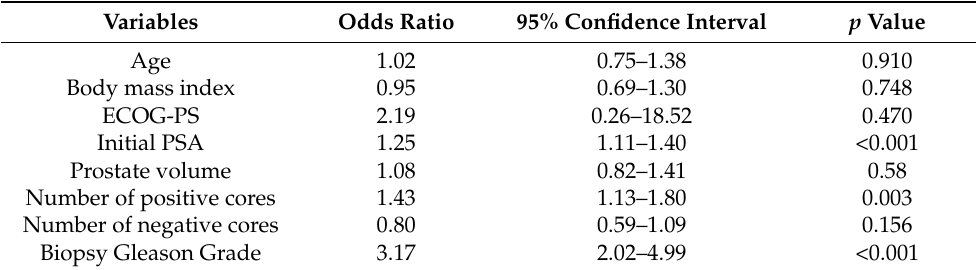
Table 2. Multivariable logistic regression analysis in the MSUG94